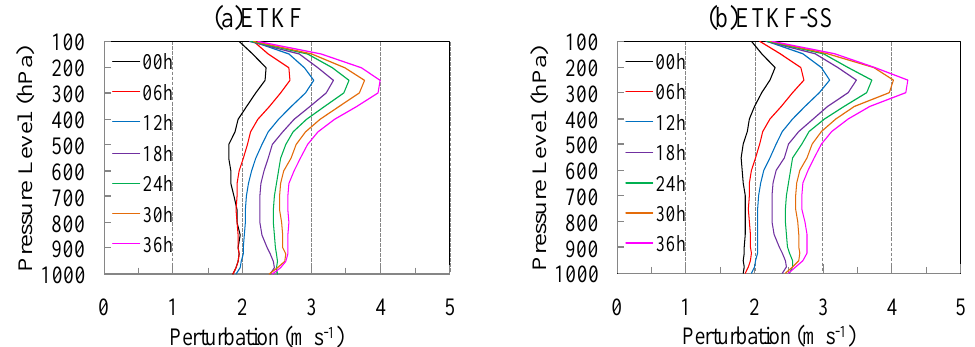
Figure 7. Vertical profile of the zonal wind perturbation at different forecast lead times of 00–36 h. ( a ) ETKF and ( b ) ETKF-SS.